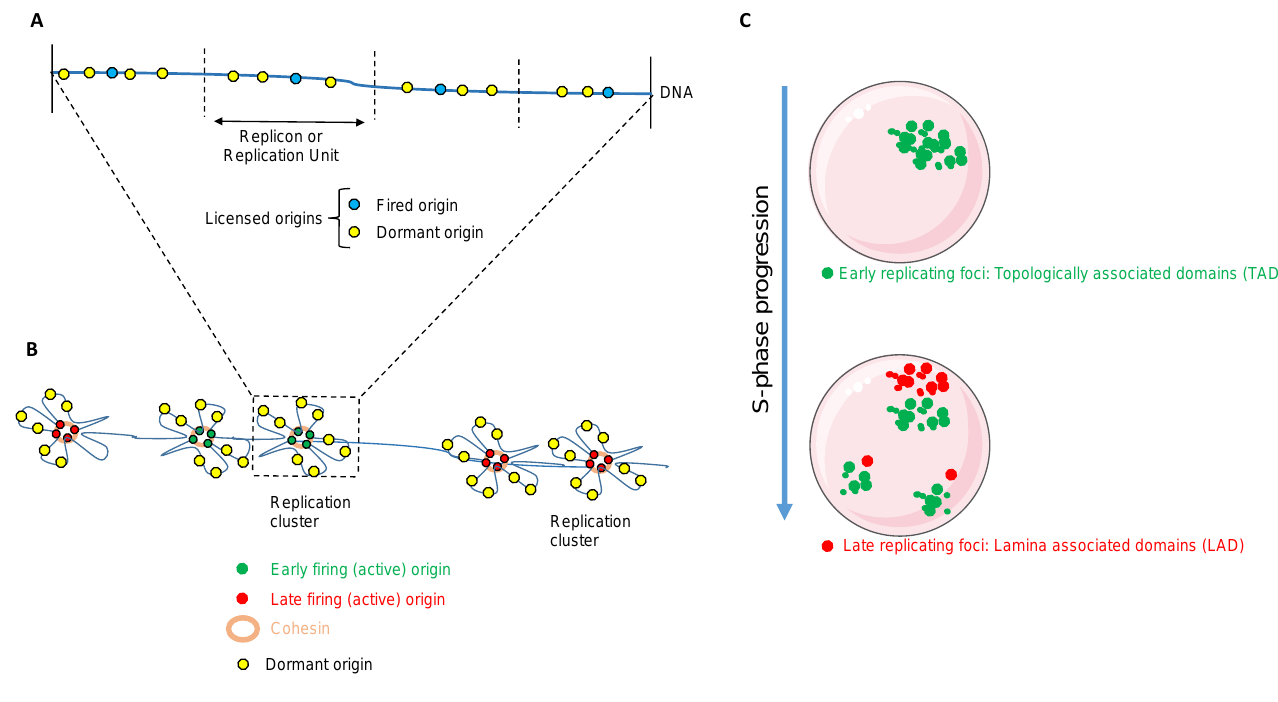
Figure 1. Spatiotemporal regulation of DNA replication. ( A ) A replicon represents the basic unit (50–450 kb), defined as a DNA segment replicated by a single active origin (blue). ( B ) Adjacent replication units are tethered together by cohesins to form a replication cluster. Origins from the same replication cluster fire at the same time either early (green) or late (red). Several replication clusters fired at the same time form a replication domain. ( C ) Early replicating foci ( ≈ replication domains) are located towards the anterior of the nucleus (green). They are replicated at the beginning of S phase and organized as TADs. Late replicating foci are located more towards the nuclear lamina hence organized as LADs (red) and are replicated at the end of S